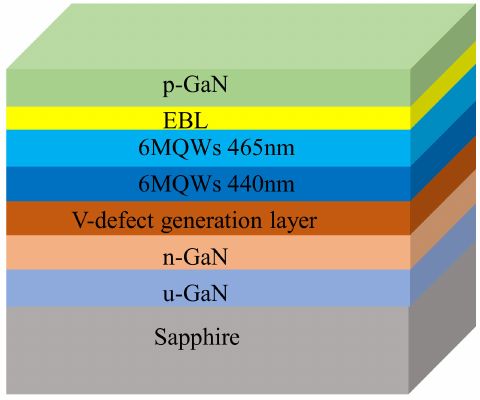
Figure 1. Schematics of epitaxial structure of multiple quantum wells (MQWs) light-emitting diodes